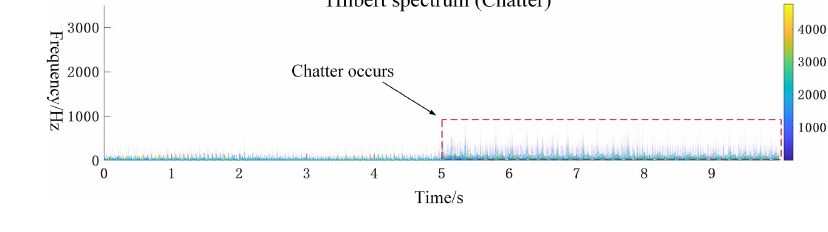
Figure 16. The a 4 frequency band.